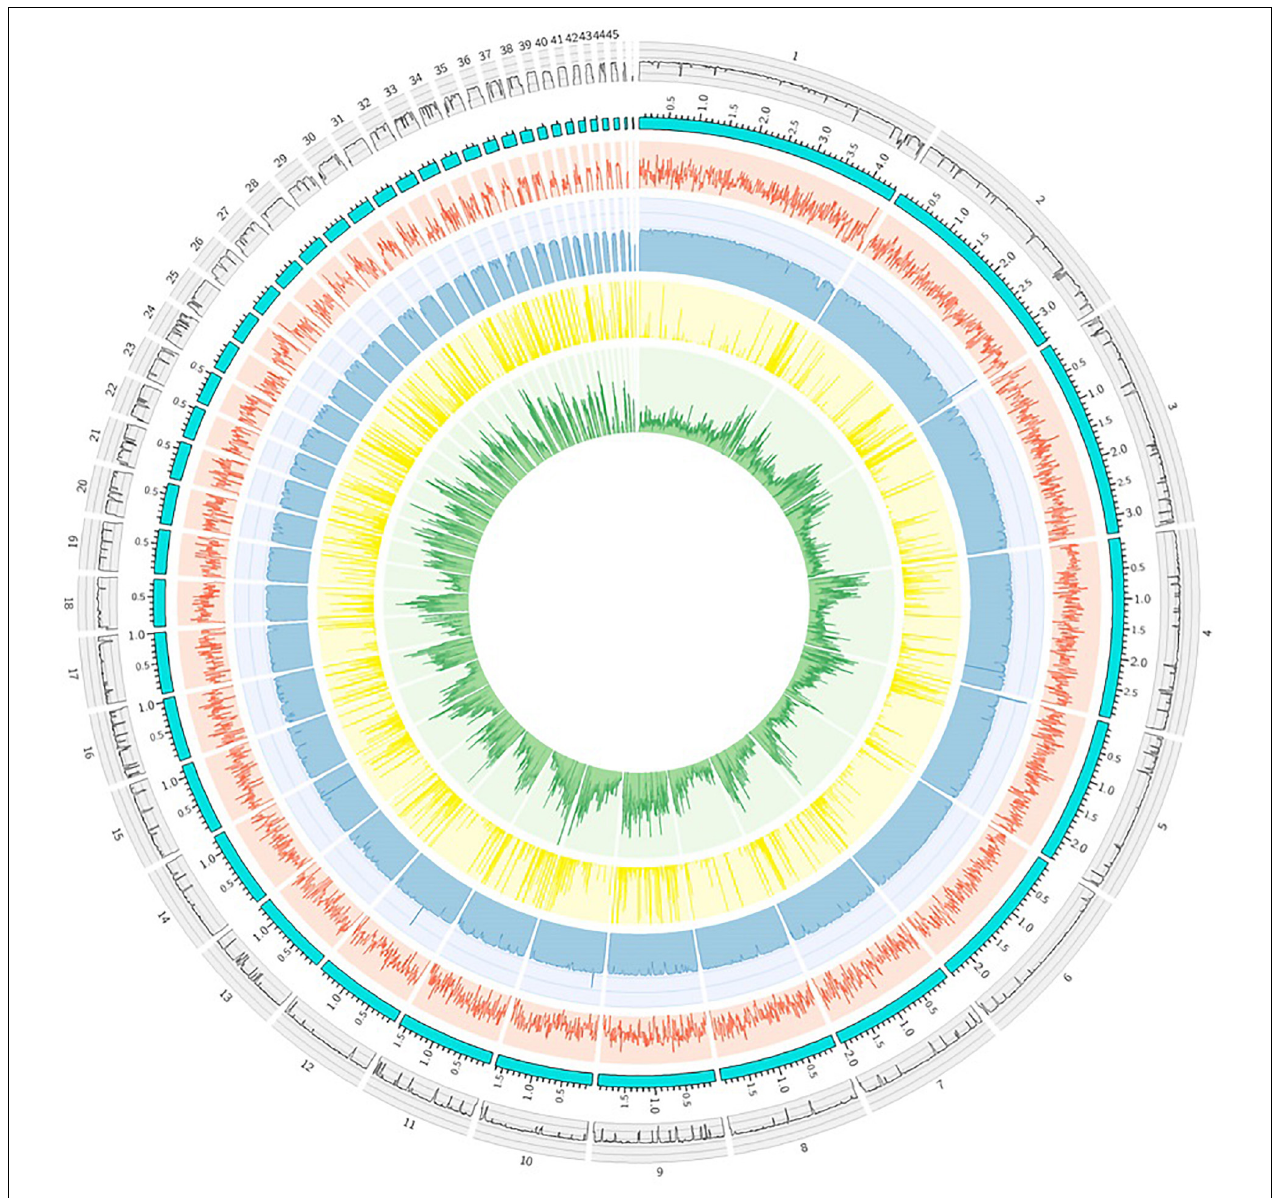
FIGURE 3 | Distribution of genes, RNA-seq reads, and genetic variations across the FS66 genome. The data shown in this graph were calculated in 10 kbp continuous non-overlapping windows across the genome. From outer to inner: the GC content (GC%) panel (black); the ideogram (sky blue) of the 47 non-organelle contigs arranged by contig size; the gene count panel (red) showing the number of annotated genes; the RNA-seq panel (light blue) in which the log 2 (read count mapped in each window) was shown; the unaligned region panel (yellow) which depicted the unaligned length between FS66 and Fs str. NRRL 66326 in each window; the SNP count panel showing the number of SNPs (including small indels) between FS66 and Fs str. NRRL